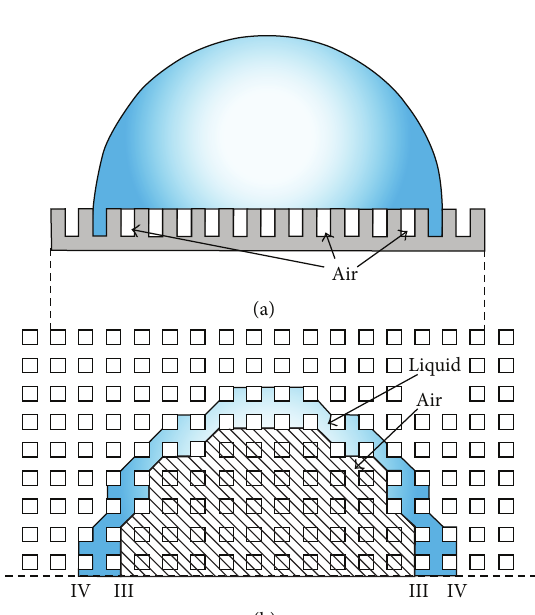
Figure 4: One-dimensional scenario of Wenzel state.